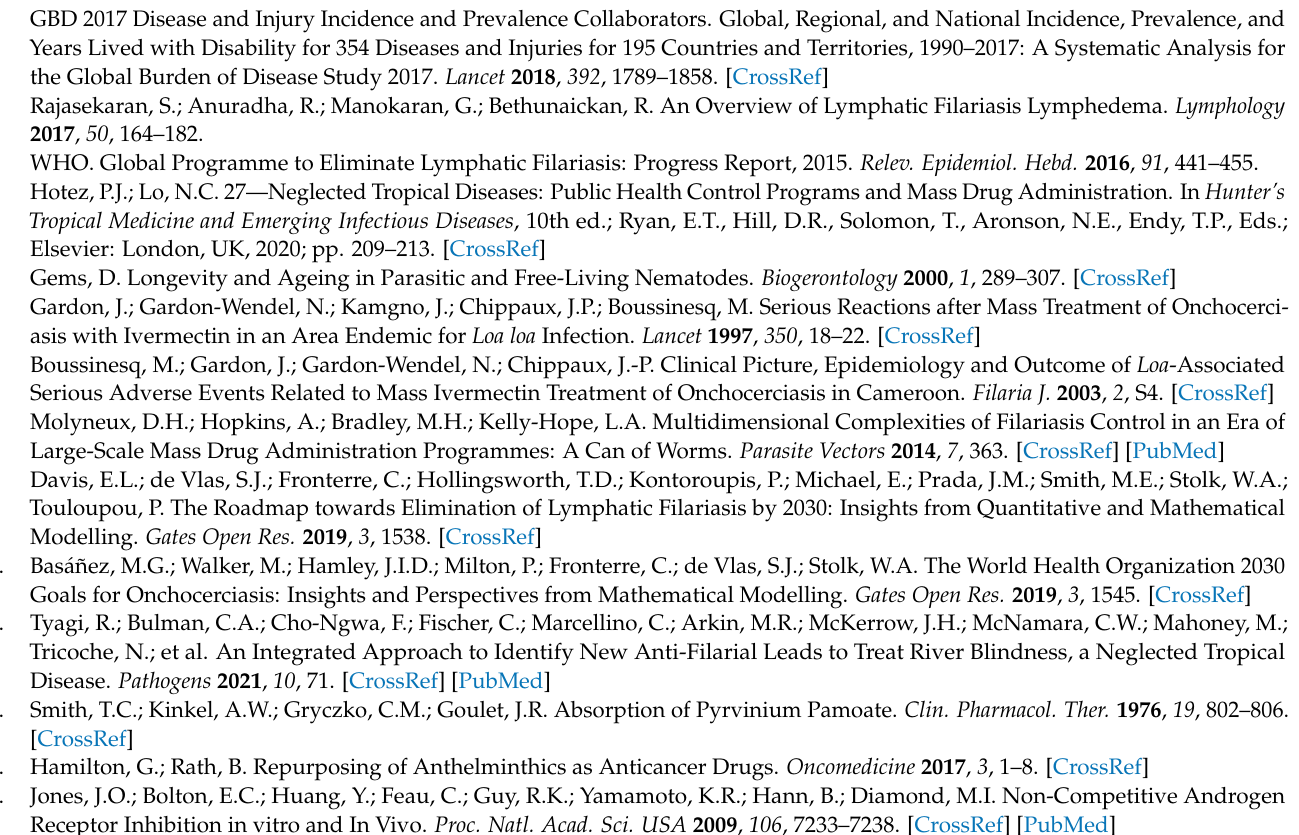
Table S1: MTT assays; Table S2: Embryogram